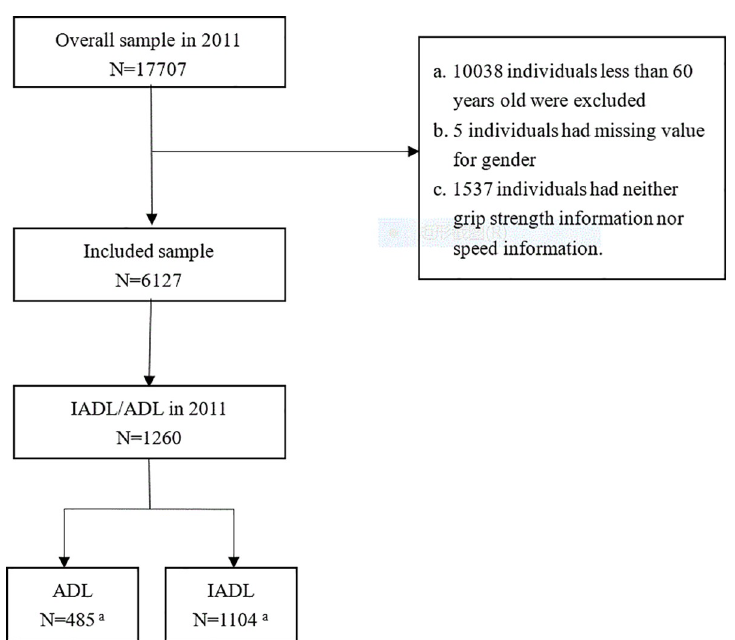
Fig 1. Participants’ flow in the study. IADL, instrumental activities of daily living; ADL, activities of daily living. a. 1104 IADL and 485 ADL disabled persons both include 329 persons with IADL and ADL disabilities simultaneously.